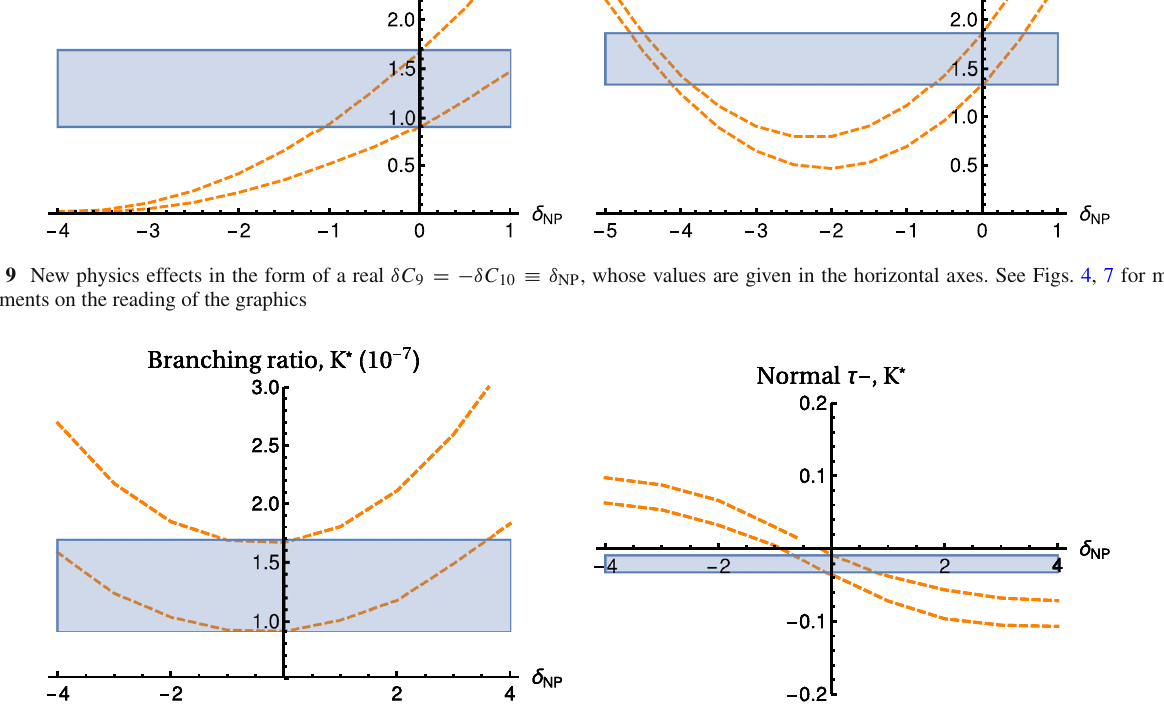
Fig. 10 New physics effects in the form of an imaginary δ C 9 ≡ i δ NP . The values for the real δ NP are given in the horizontal axes. See Fig. 4 for more comments on the reading of the